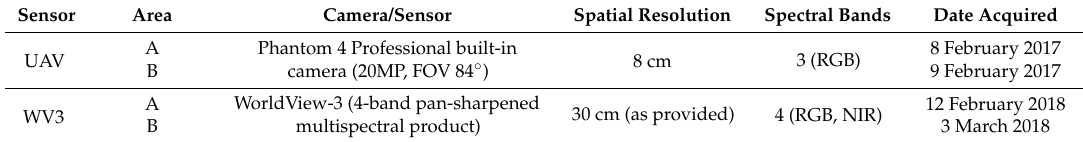
Table 3. Technical specifications of the sensors used in the study and image acquisition dates.